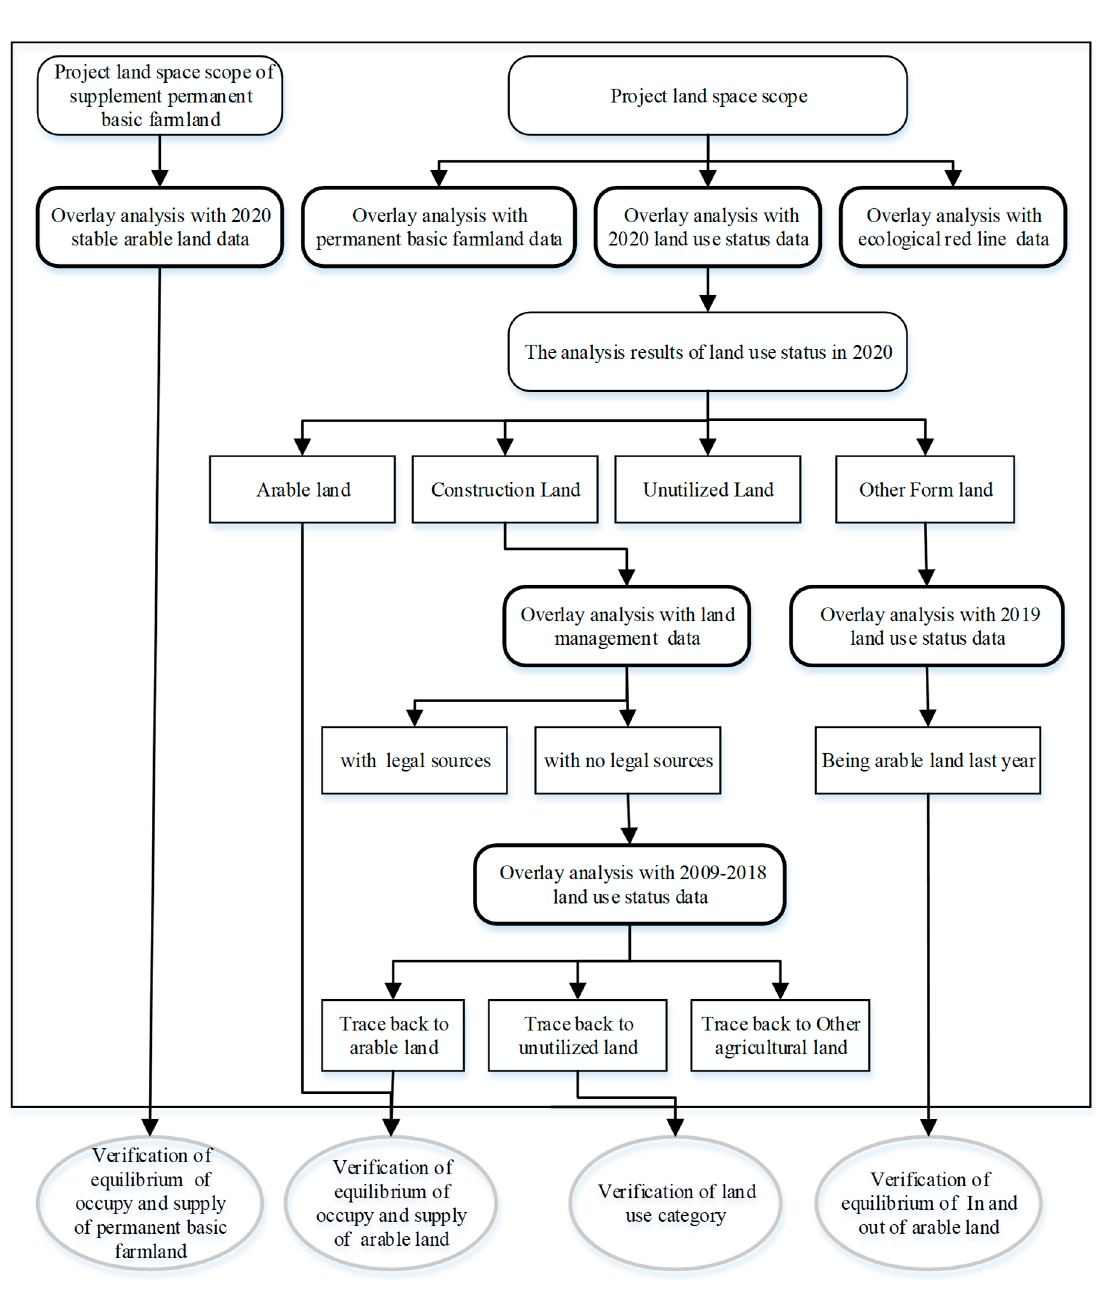
Figure 4. Spatial information verification business model of construction land approval.